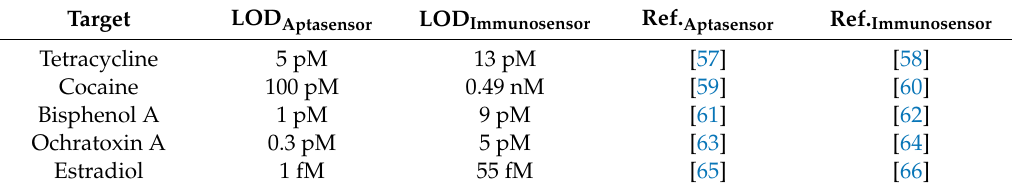
Table 2. Selection of superior aptasensors for the detection of small molecules compared with the most e ffi cient immunosensor alternative based on limit of detection (LOD)